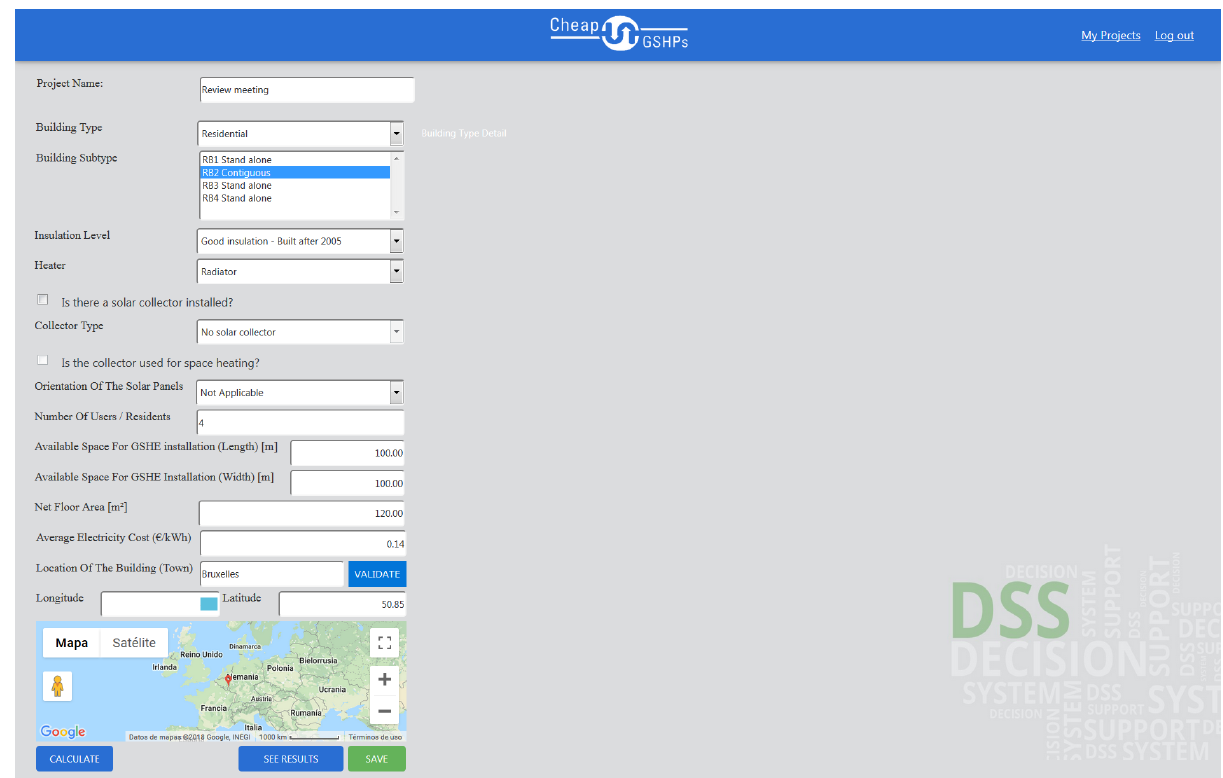
Figure 2. The DSS Website – Facility description page (from De Carli et al.,